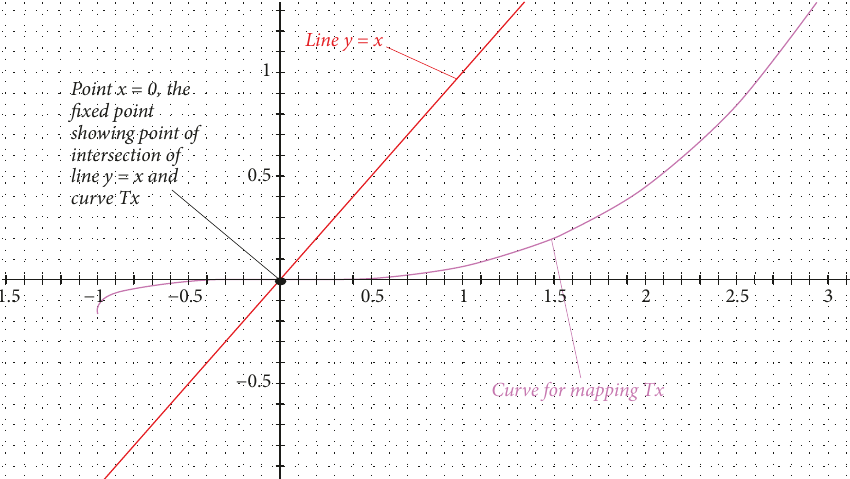
Figure 7: Plot showing Fixed point of 𝑇𝑥